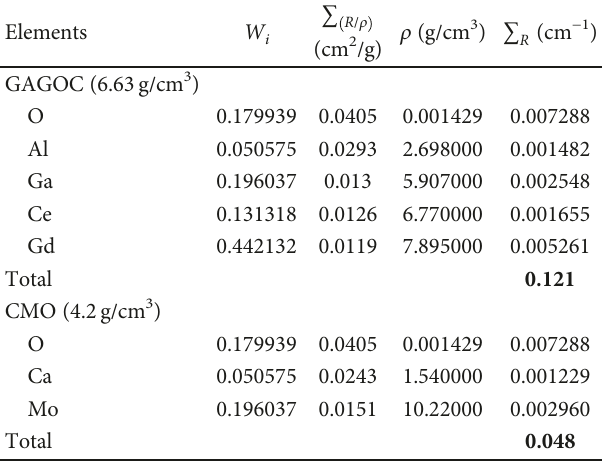
Table 6: Calculation values of the fast neutron e ff ective removal cross-sections for GAGOC and CMO.